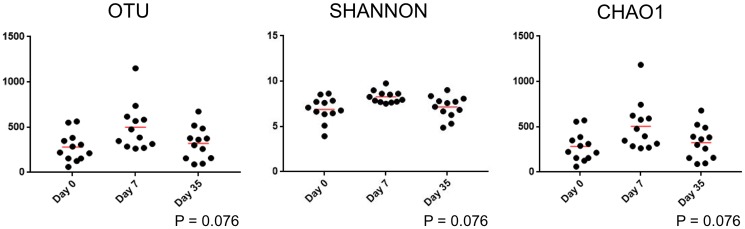
Scatter plots and statistical evaluation of 16S-rRNA gene sequences obtained from 12 treatment eyes of 12 healthy horses at 3 timepoints: Baseline (day 0), after one week of topical antibiotic therapy (day 7), four weeks after discontinued topical antibiotic therapy (day 35).There is no difference in alpha diversity in treated eyes over time (Freidman test and Dunn’s post-test).